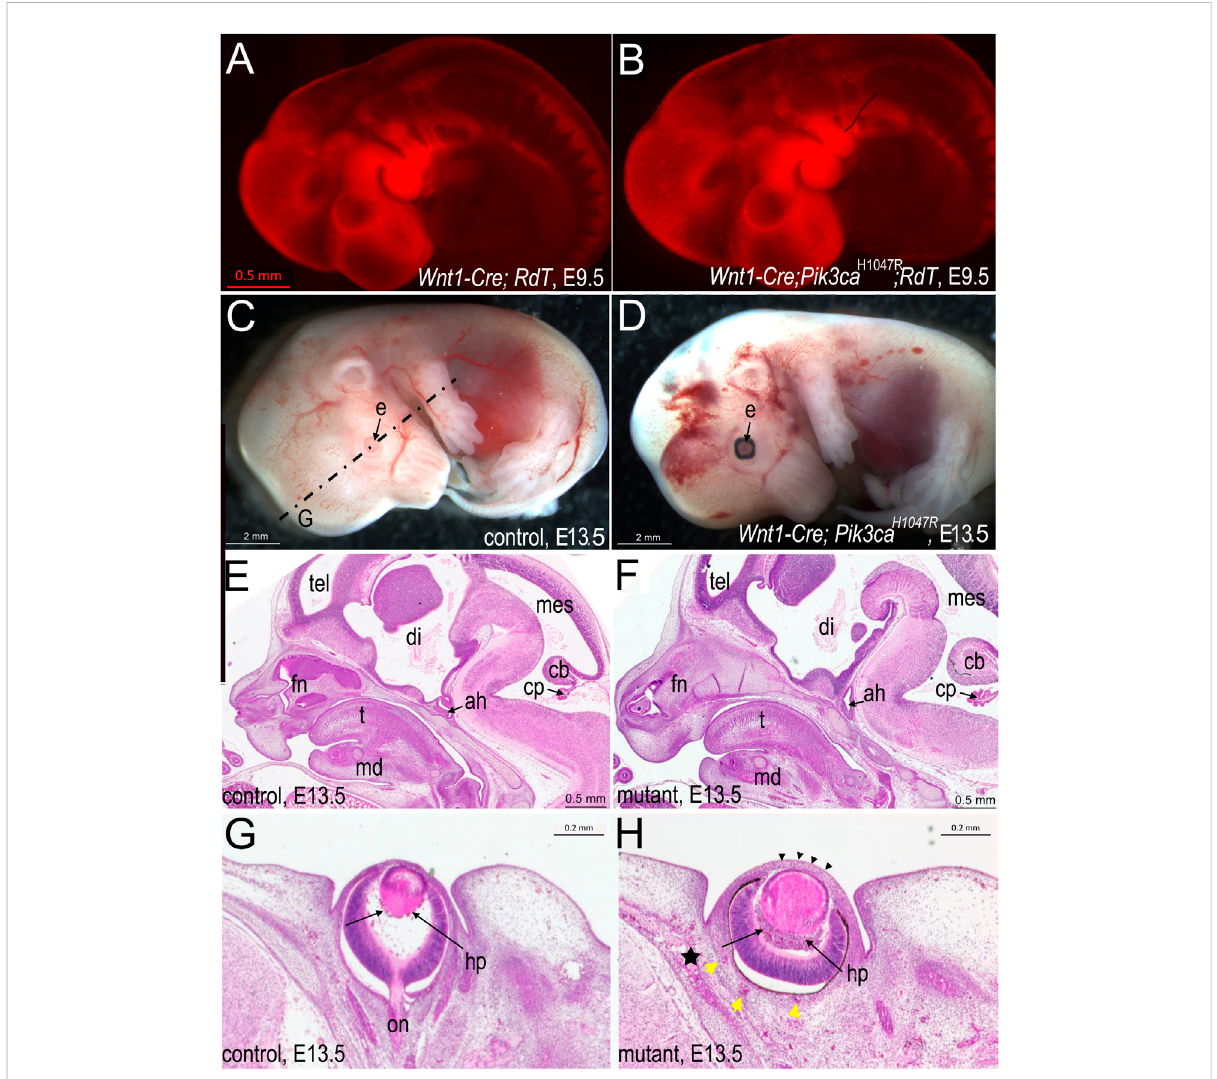
Phenotypesof Wnt1-Cre +/ ° ; Pik3ca H1047R/+ embryosfromE9.5toE13.5. (A) Whenlineage-tracedbyco-expressionofa RdT +/ ° alleletotranscribe Tomatored fl uorescentproteinincellshavingexpressedWnt1, Wnt1-Cre +/ ° ; RdT +/ ° embryosatE9.5showthenormaldistributionofneuralcrest(NC) mesenchyme in the face and pharyngeal arches. Bars = 0.5 mm for (A), (B). (B) Wnt1-Cre +/ ° ; Pik3ca H1047R/+ ; RdT +/ ° embryos at E9.5 show unaltered distribution of NC-derived mesenchyme in the pharyngeal arches, frontonasal bud or body. (C) Left side of E13.5 control littermate to (D). Lack of pigment in retinal pigmented epithelium of eye is normal for a mouse that would have been born albino ( Tyr c / Tyr c ), a background allele (http:// www.informatics.jax.org/allele/MGI:1855976). Dotted lines indicate plane of frontal section in G. Bars = 2 mm for C, D. e, eye. (D) Left side of E13. 5 Wnt1-Cre +/ ° ; Pik3ca H1047R/+ littermate to (C) , showing vascular anomalies and cerebral hemorrhage. Probable hyaloid plexus malformation visible also in H. (E) Paraf fi n mid-sagittal section of control littermate head of (F) at E13.5, stained with HE. Bars = 0.5 mm for E, F. Abbreviations as in F. (F) Paraf fi nmid-sagittal section of mutant head atE13.5 showing enlarged frontonasal and mandibular (md) tissues, cerebellum (cb) and choroid plexus (cp), as well as a malpositioned adenohypophysis (ah) relative to the infundibulum, stained with HE. di, diencephalon; mes, mesencephalon; t, tongue; tel, telencephalon. (G) Paraf fi n frontal section of control head at E13.5, left eye at level of optic nerve (on), stained with HE. Bar for G, H = 0. 2 mm H p , hyaloid plexus. (H) Paraf fi n frontal section of mutant littermate of (G) at E13.5, left eye, showing lens hypertrophy, hyaloid plexus malformation (arrows), thickened corneal epithelium (black arrowheads) and scleral (yellow arrowheads) and perichondral vascular malformation (star), stained with